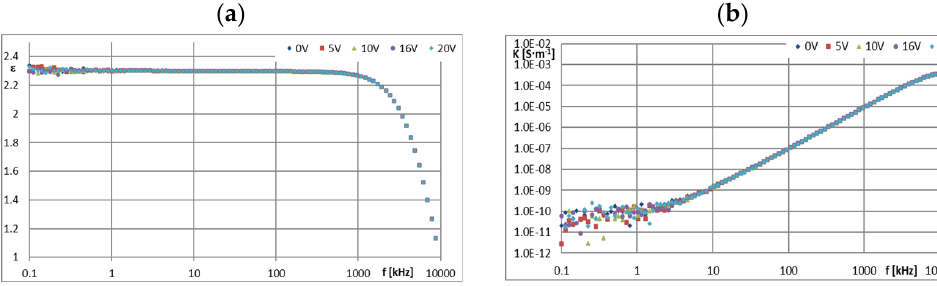
Figure 7. Characteristics: ( a ) ε = f( f ) and ( b ) κ = f( f ) for GP1 at different values of U.